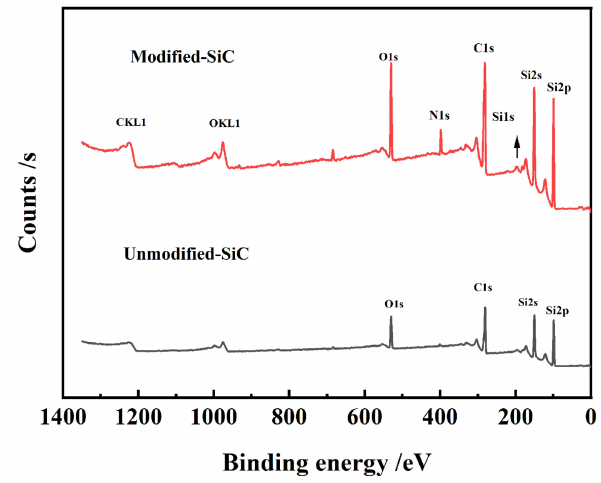
Figure 8. X-ray photoelectron spectroscopy (XPS) spectra of as-received SiC and PVP-adsorbed SiC